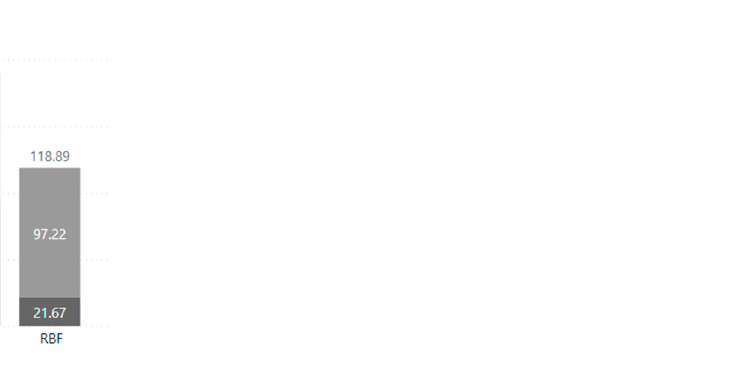
Figure 12. Comparison of the sum of detection accuracy between internal and external faults in each detection method (average of cases 1 and 2).